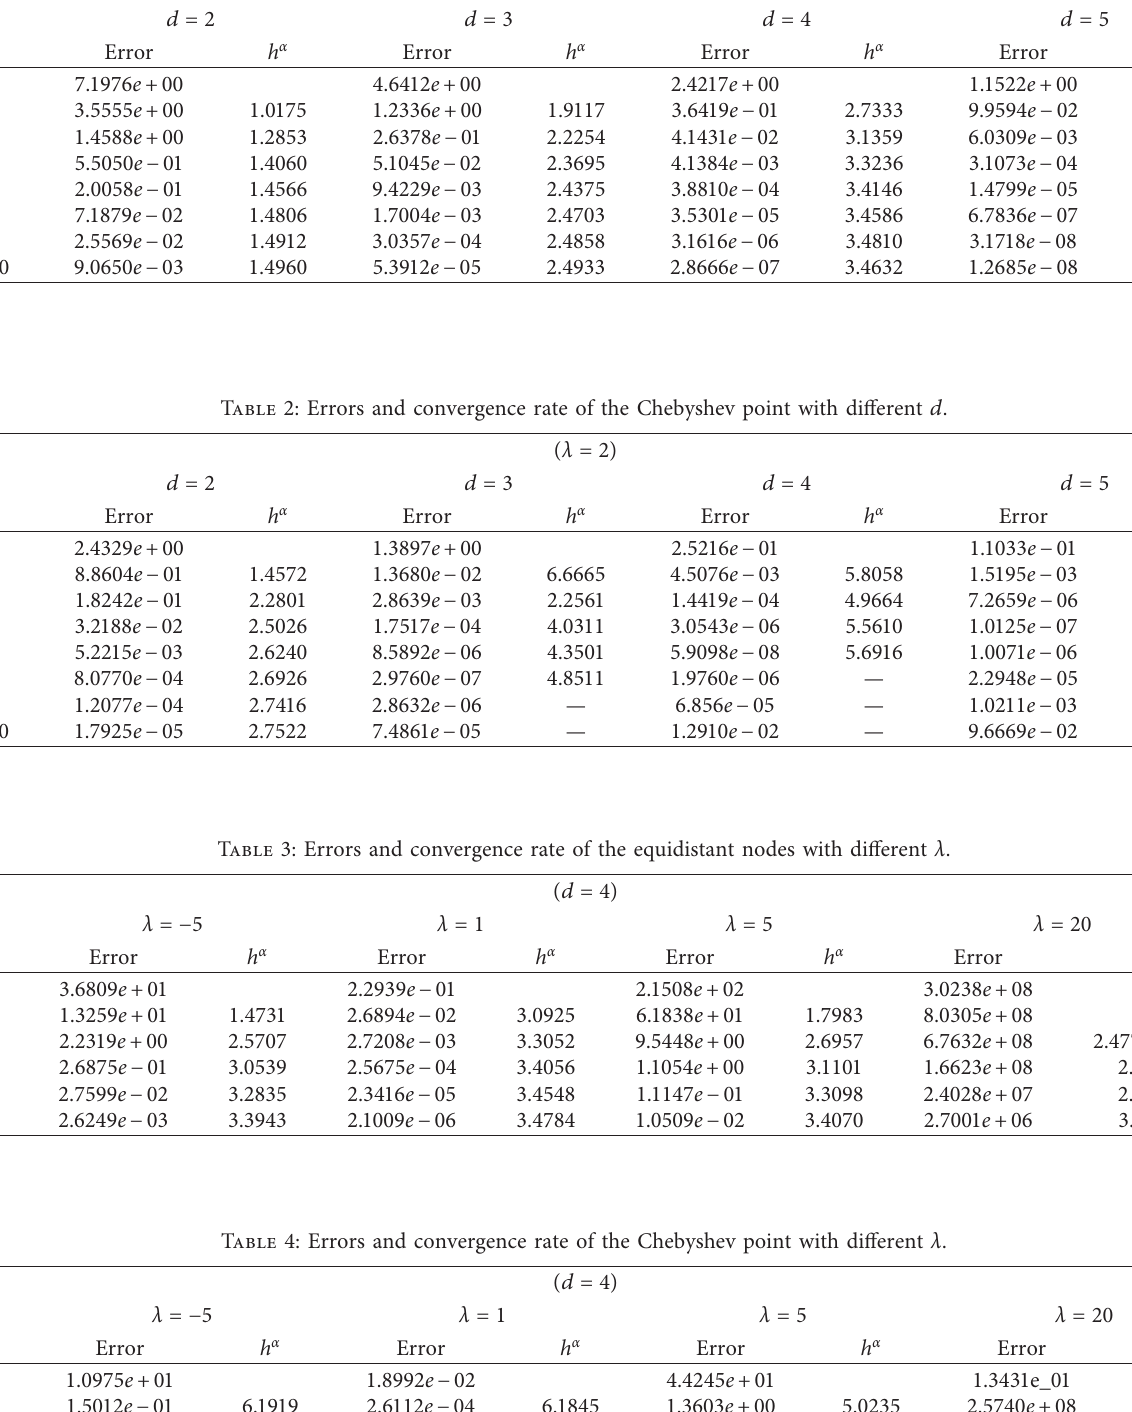
Table 1: Errors and convergence rate of the equidistant nodes with different d